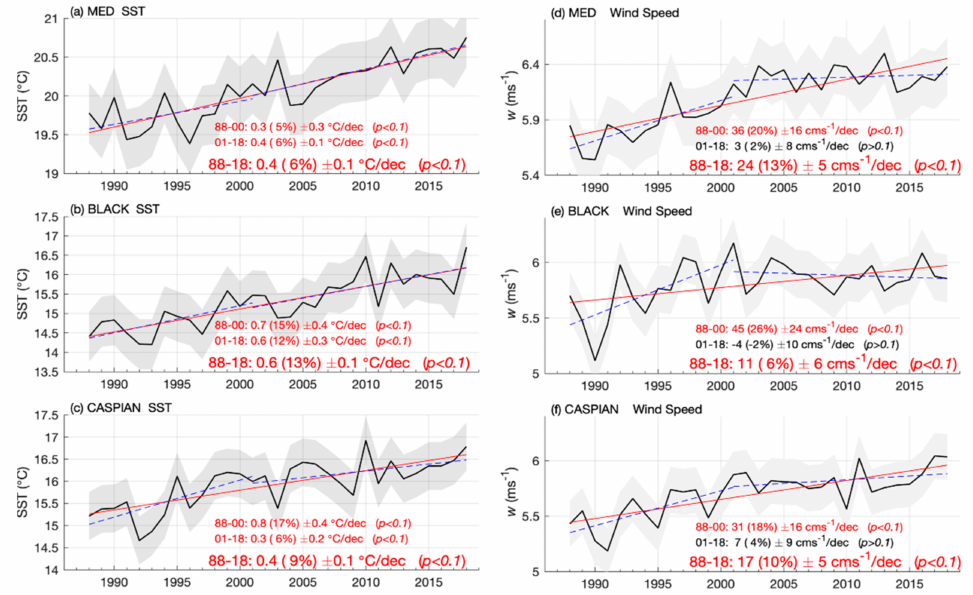
Figure 13. Basin-averaged annual time series (black line) of ( a – c ) SST and ( d – f ) wind speed for the South European marginal seas. ( a , d ) MED: the Mediterranean Sea. ( b , e ) BLACK: the Black Sea. ( c , f ) CASPIAN: the Caspian Sea. The shaded area denotes one standard deviation of annual-mean variability. The red line denotes the linear trend over 1988–2018, and the dashed blue lines are the linear trends over 1988–2000 and 2001–2018, respectively. Linear trend estimates for the three periods are listed: 1988–2000 (top line), 2001–2018 (middle line), and 1988–2018 (bottom line), colored by red if the trend is statistically significant ( p < 0.1) or by black if the trend is statistically not significant ( p > 0.1). The value in the parentheses is the percentage